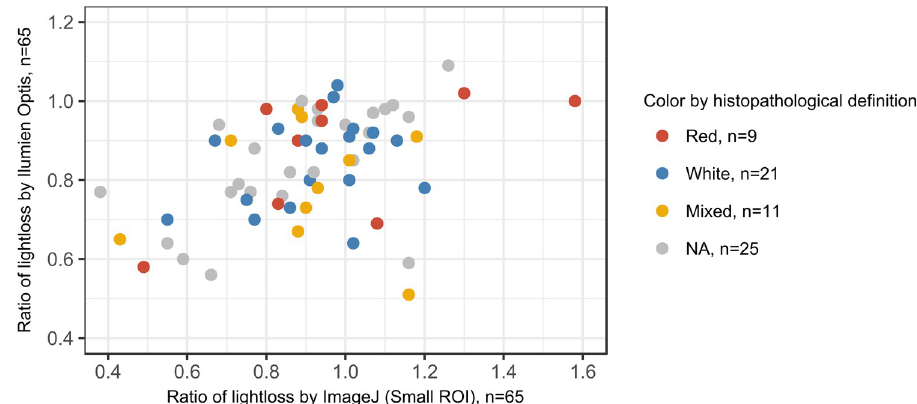
Fig 2. Comparison between ratio of lightloss measured by Ilumien Optis and ImageJ softwares with correlation 0,40 (p = 0,0001).